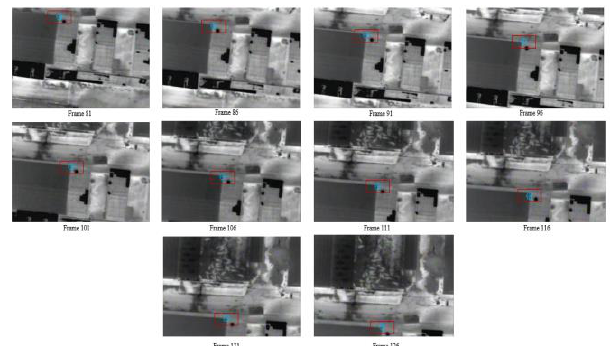
Figure 6: Target tracked in the sequence of successive frames